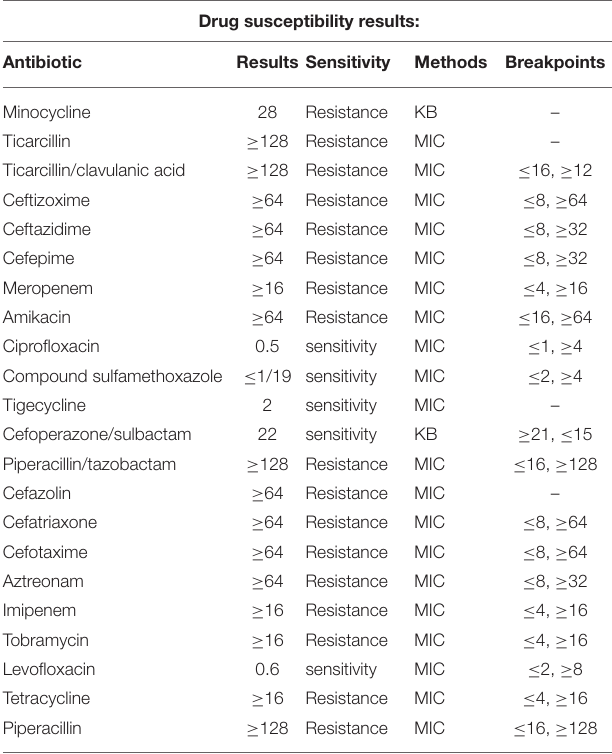
TABLE 1 | Cerebrospinal fluid culture and drug sensitivity.